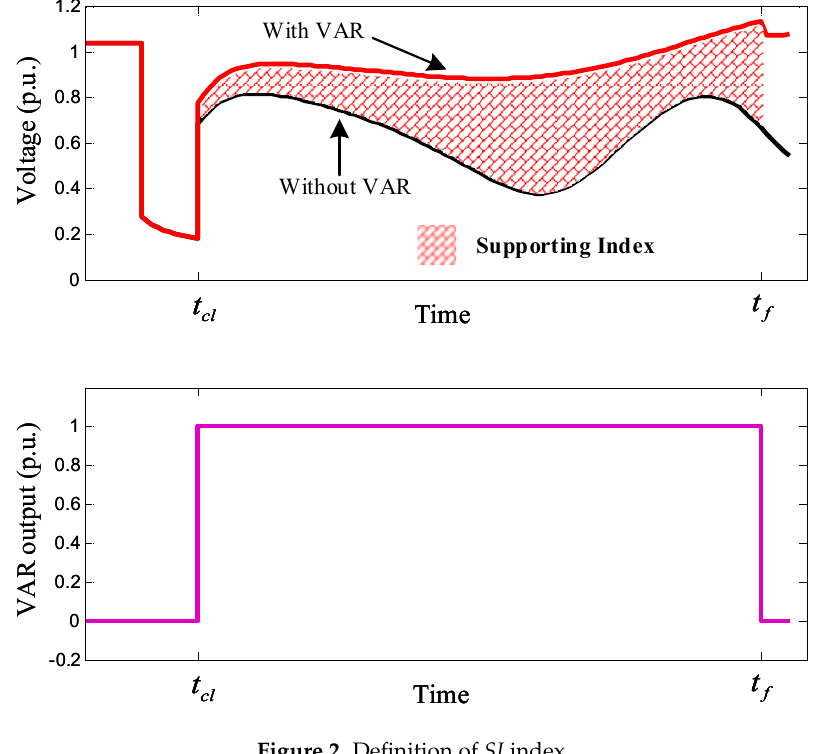
Figure 2. Definition of SI index.